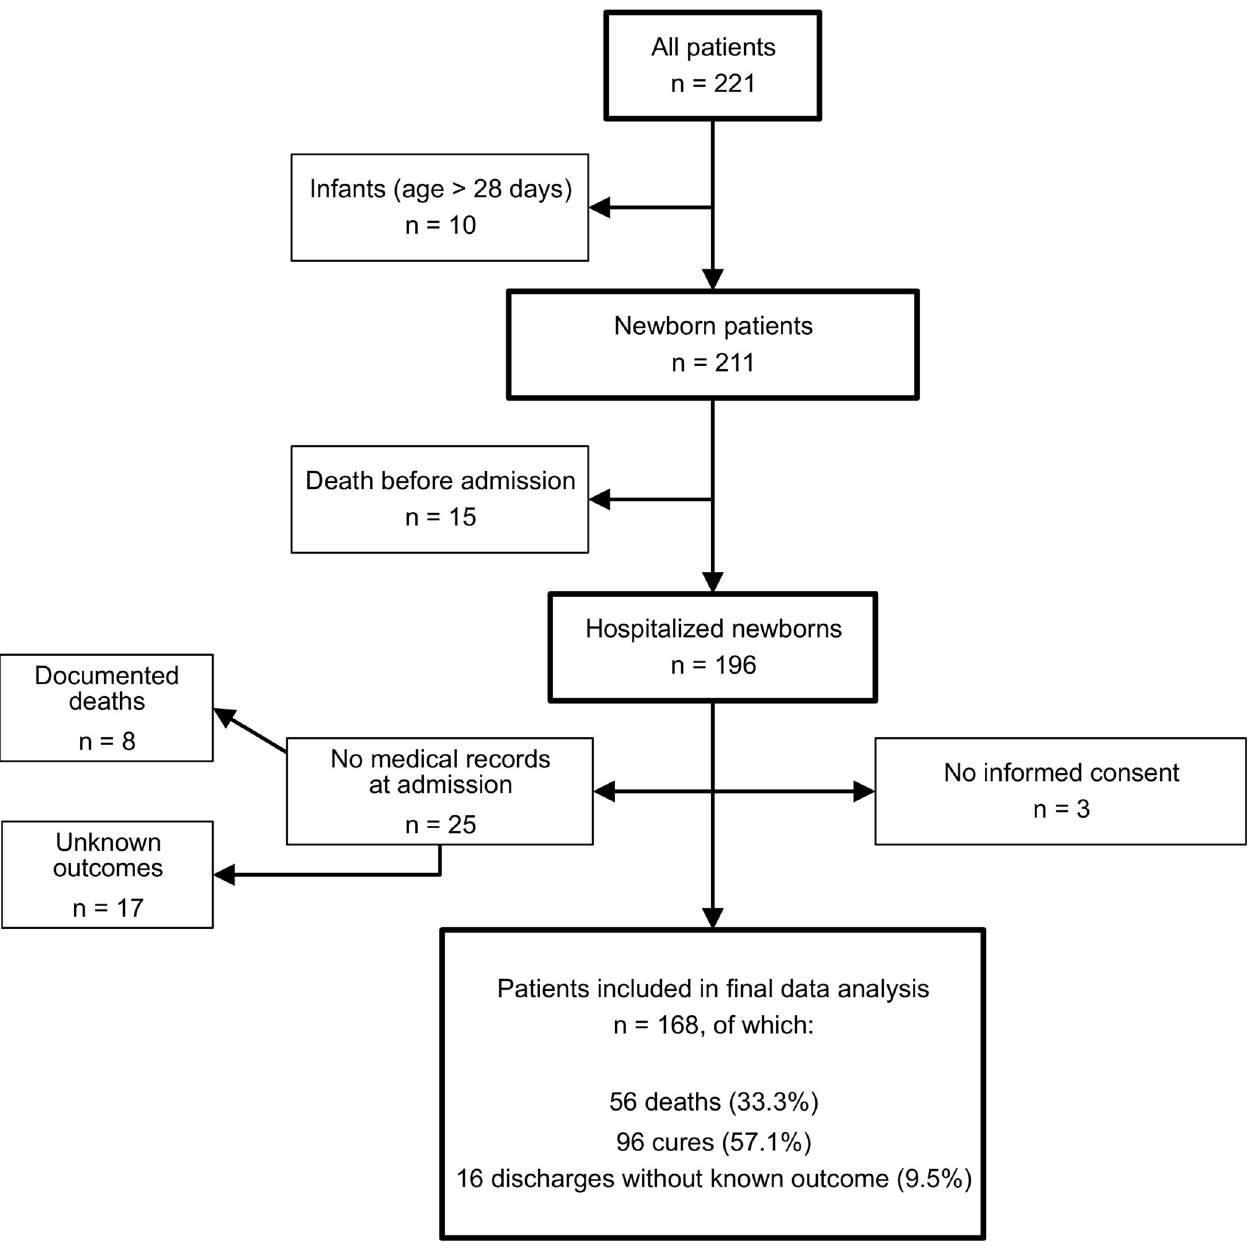
Fig 1. Flow diagram of all included and excluded newborns in the study and their final outcome. https://doi.org/10.1371/journal.pone.0254938.g001 rates incorporating the excluded infants were calculated: Considering the eight children that died at admission, the mortality rate rose to 36.4% (64/176, 95%-CI 0.30–0.44). Counting the 15 neonates that died before arrival at INSE, the mortality rate increased to 41.4% (79/191, 95%-CI 0.35–0.48). Out of the included 168 neonates, 96 (57.1%) left the hospital cured; 16 infants (9.5%) were discharged prematurely, either because their parents refused further care (12/168, 7.1%) or because they were transferred to other clinics, e.g., pediatric surgery (4/168, 2.4%). Information about their outcome is not available.